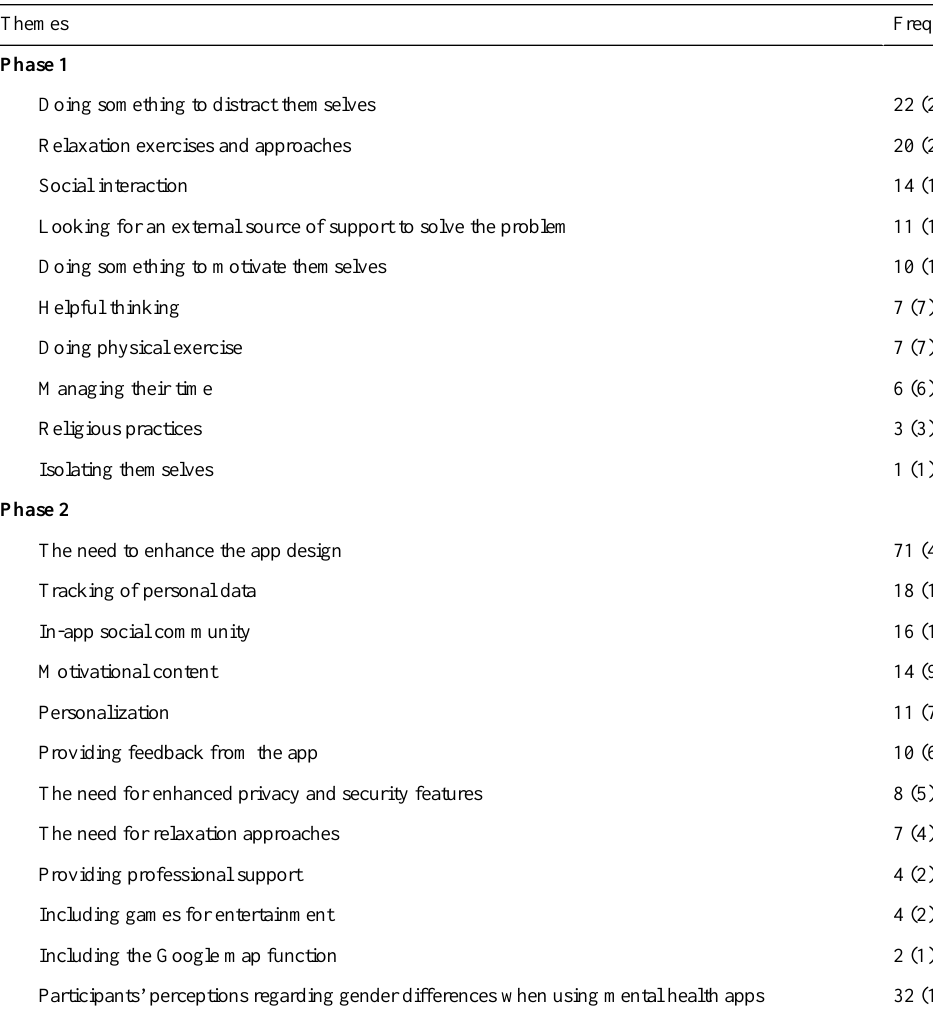
Table 2. Coding frame detailing the frequency of occurrence of the themes within the